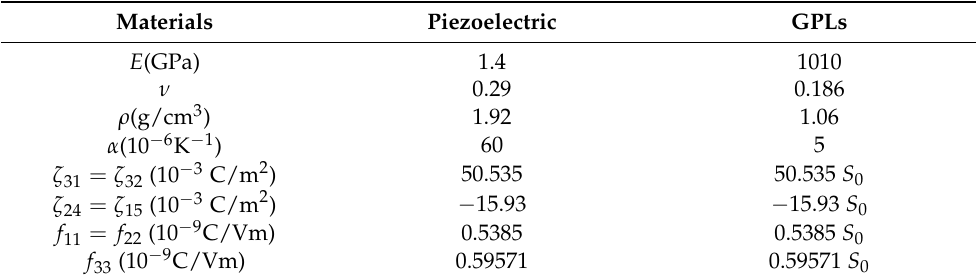
Table 1. Material properties of the piezoelectric matrix and GPLs [44].